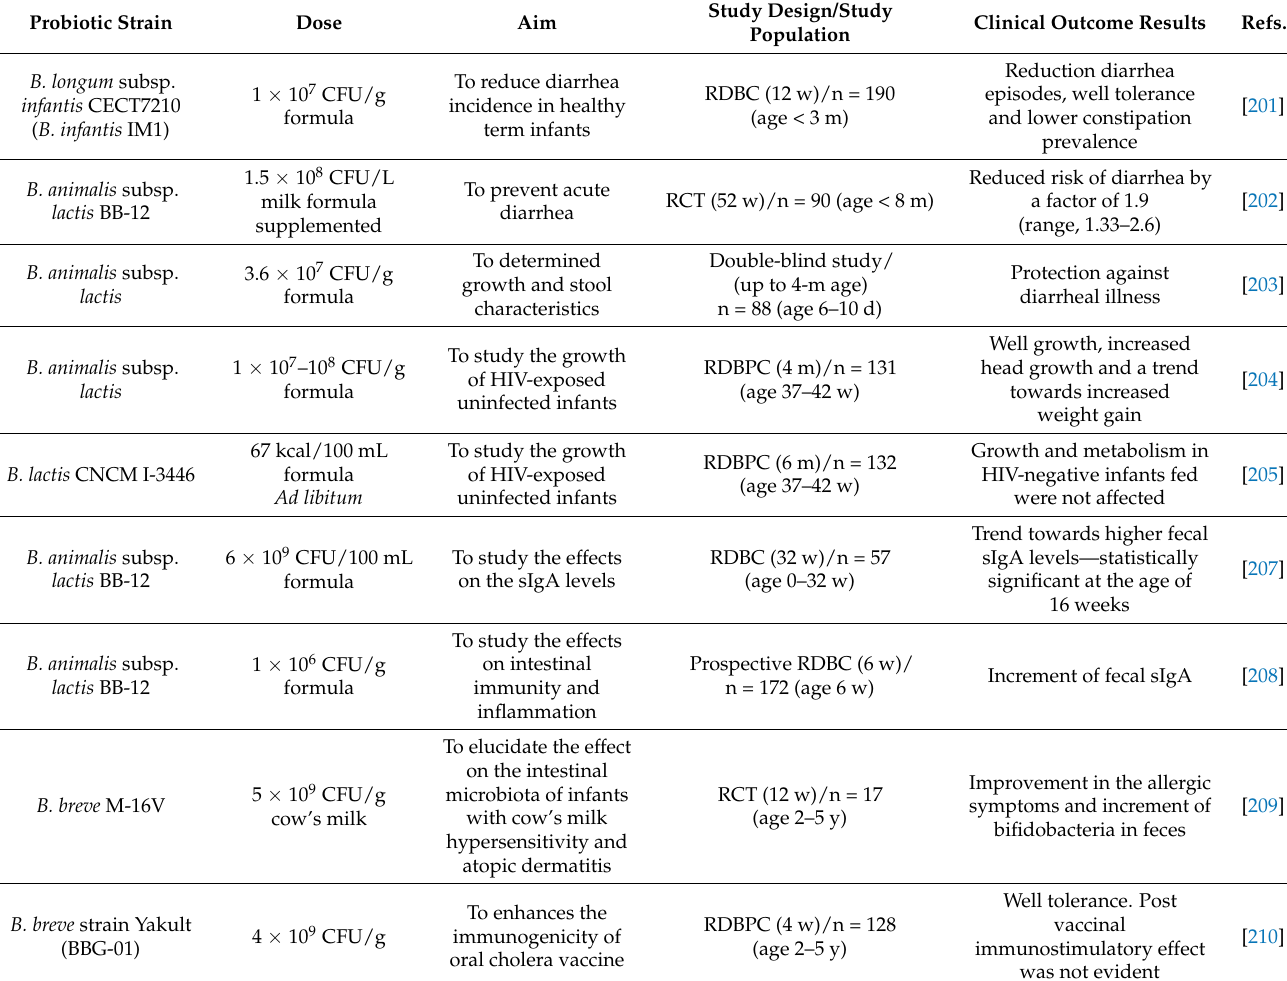
Table 2. Clinical studies and beneficial effects of Bifidobacterium strains on infants. Probiotic Strain Dose Aim